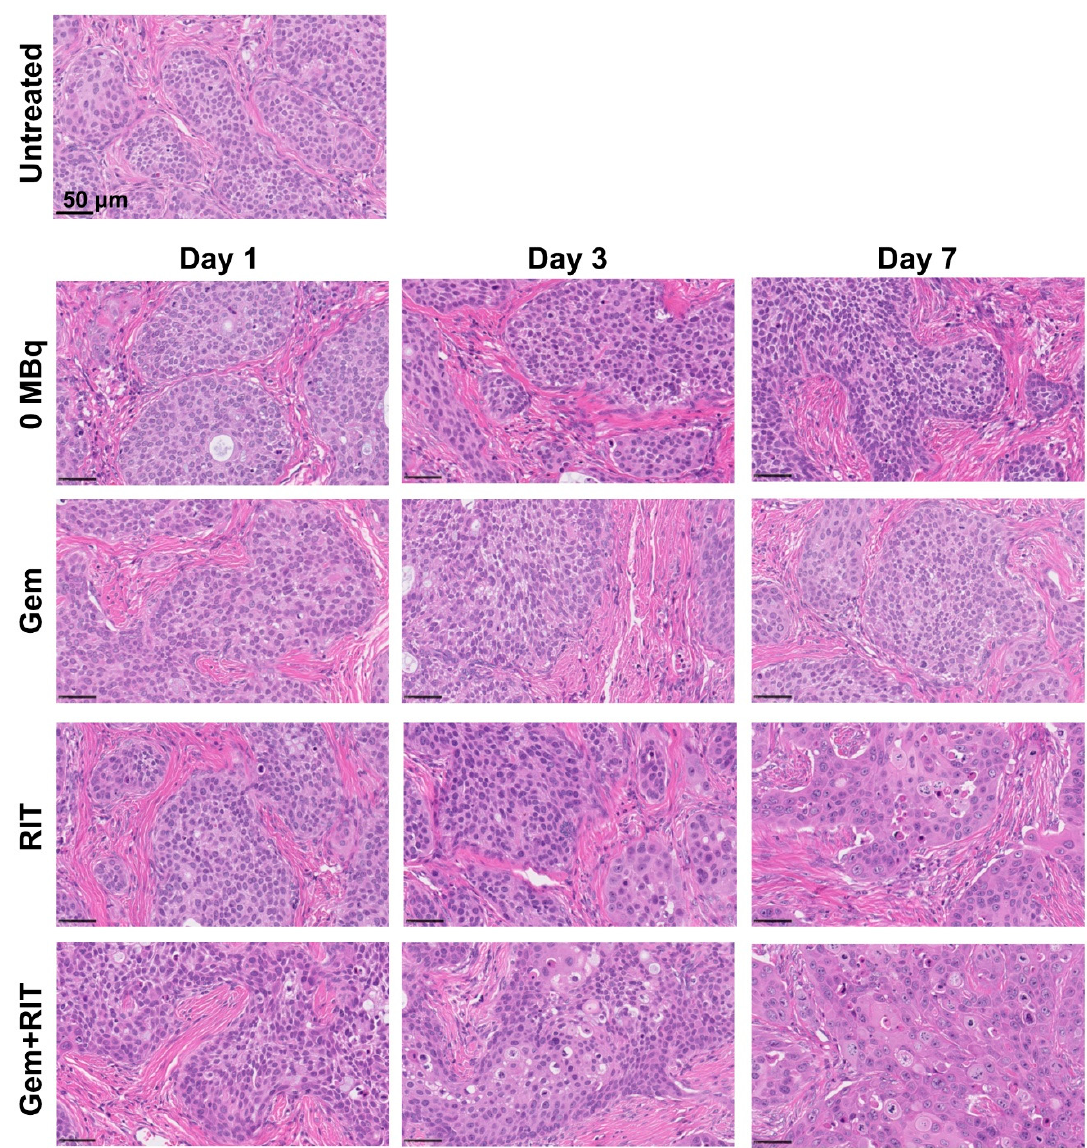
Figure 7. H&E-stained BxPC-3-tumor sections at days 1, 3, and 7 after i.v. injection of intact anti-CD147 antibody 059-053 (0 MBq), gemcitabine (gem, 240 mg/kg body weight) alone, 3.7 MBq of 90 Y-labeled 059-053 (RIT) alone, and the combination of gem plus RIT (one-cycle regimen).